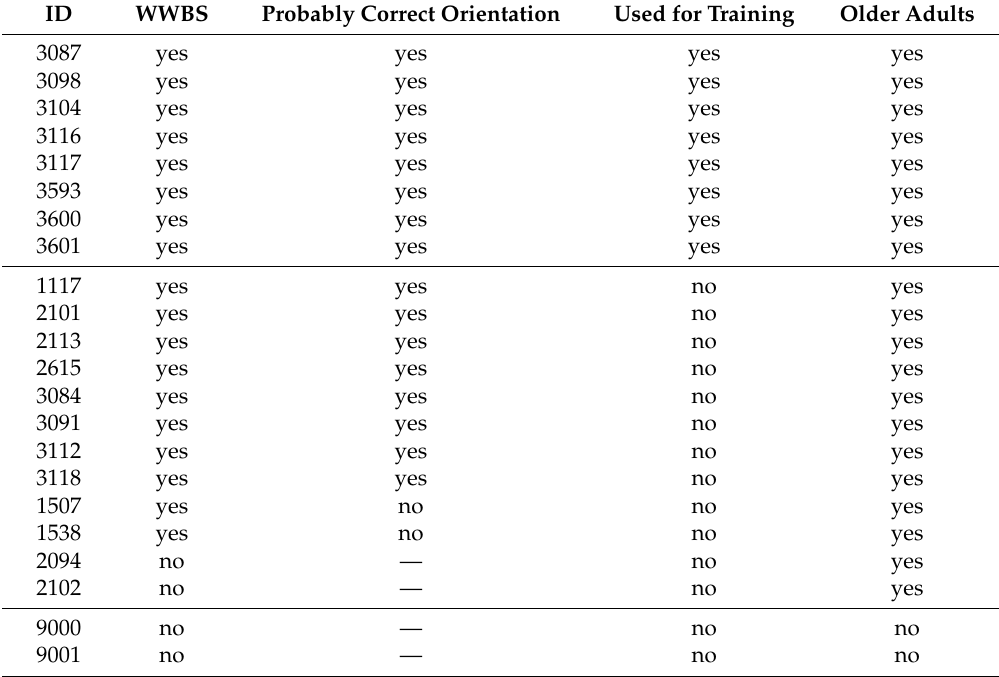
Table 1. Characteristics of recordings and data split for evaluation. Orientation consistency could not be visually determined across devices, and is therefore not marked. ID WWBS Probably Correct Orientation Used for Training Older